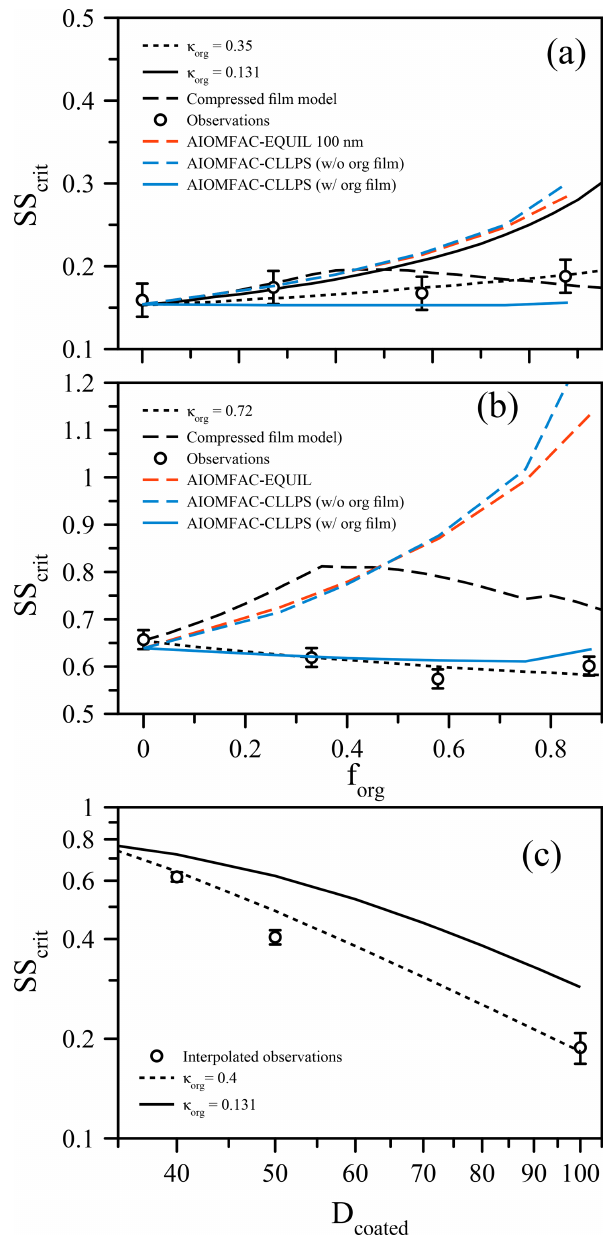
Figure 2. (a) Measured critical supersaturation (SS crit ) of size- selected ammonium sulfate particles coated with suberic acid (points) to a set dry diameter of 100nm at T ≈ 293K. The curves show predictions from the compressed film model of Ruehl et al.. (2016), a simple κ -Köhler model with constant surface ten- sion, and model variants from the AIOMFAC-based framework (see text). (b) Analogous to (a) but for particles of ammonium sulfate coated to 40nm dry diameter by suberic acid. (c) Using the data from (a) and (b) , SS crit is shown as a function of coated diameter with a fixed inorganic seed of 33nm (points). The lines indicate the κ -Köhler model with constant surface tension using different but constant values of κ org